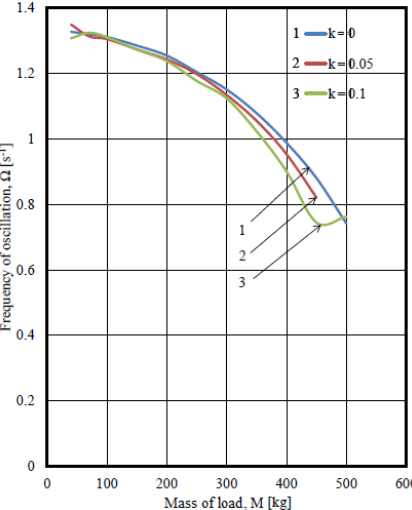
Figure 25. Modulated amplitude frequency responses of oscilla- tions of angular velocity of the driving link of mechanism in dif- ferent values of coefficient of sliding friction and rotational friction k = 0.